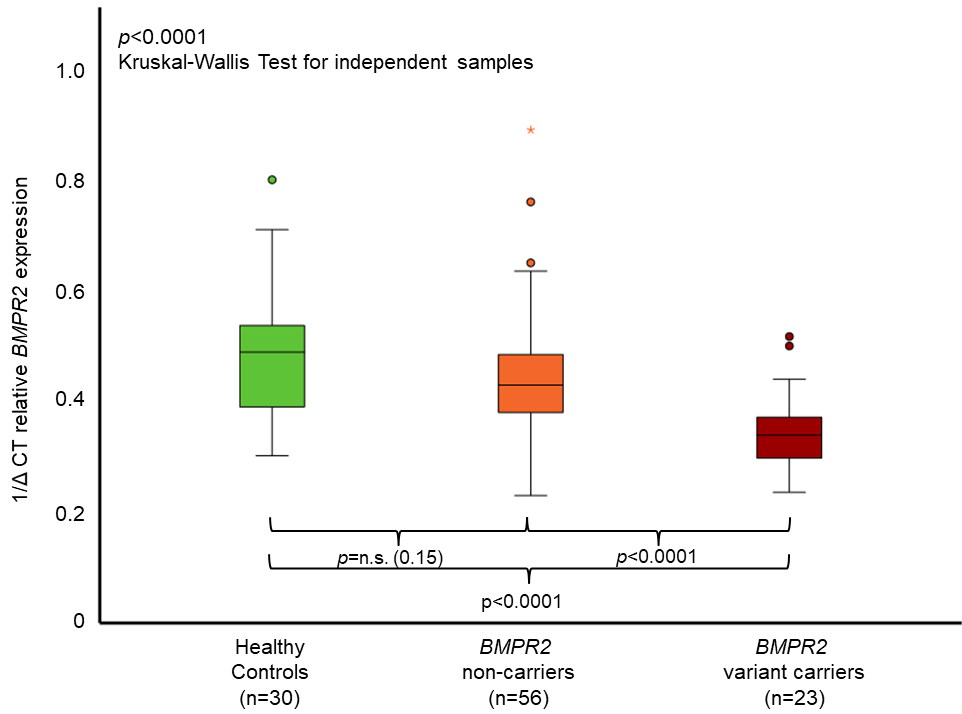
Figure 2. Mean relative BMPR2 mRNA expression in whole blood. The boxplots provide median values (horizontal lines), interquartile range (box), 1.5× interquartile range (whiskers), outliers (indicated by circles within 1.5 to 3× interquartile range) and extreme outliers (indicated by asterisks > 3× interquartile range). A significant difference of BMPR2 mRNA expression could be identified between healthy controls, BMPR2 non-carriers and BMPR2 variant carriers. With Bonferroni correction, p -values were healthy controls vs. non-carriers p = 0.453, non-carriers vs. variant carriers p = 0.0002, and healthy controls vs. variant carriers p < 0.0001. The 1/delta cycle threshold (1/ ∆ CT) denotes the level of BMPR2 mRNA gene expression measured by qPCR. n.s. = non-significant.